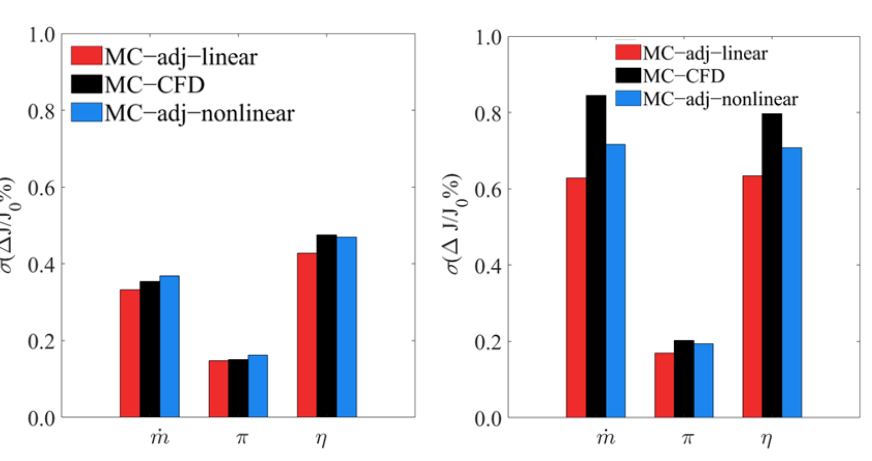
Figure 12. The normalized standard deviation of performance functionals variation at the design ( left ) and near-stall conditions ( right ) computing using the three methods.